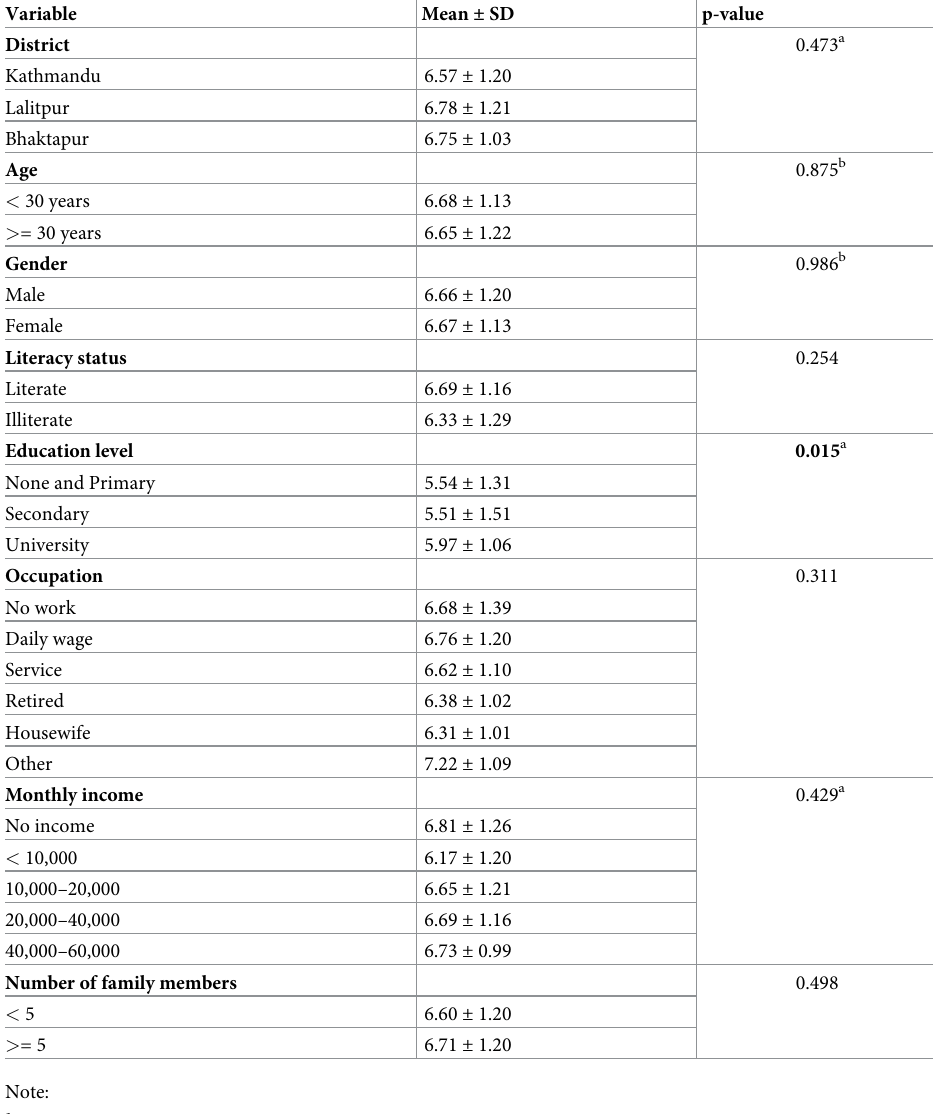
Table 3. Comparison of knowledge scores among different subgroups of